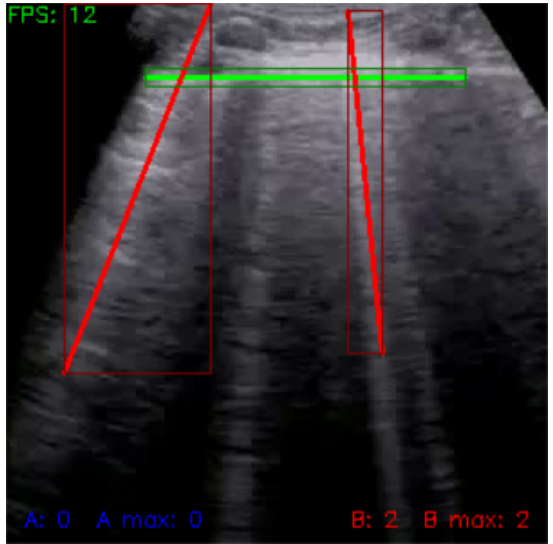
Figure 7. Frame with detected lines (green: pleura, red: